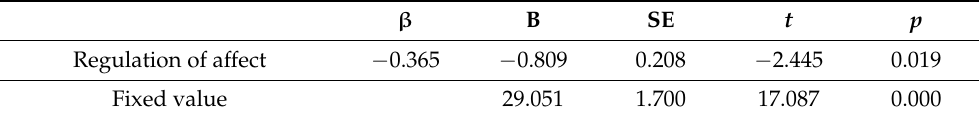
Table 9. Predictors of fighting spirit. β B p